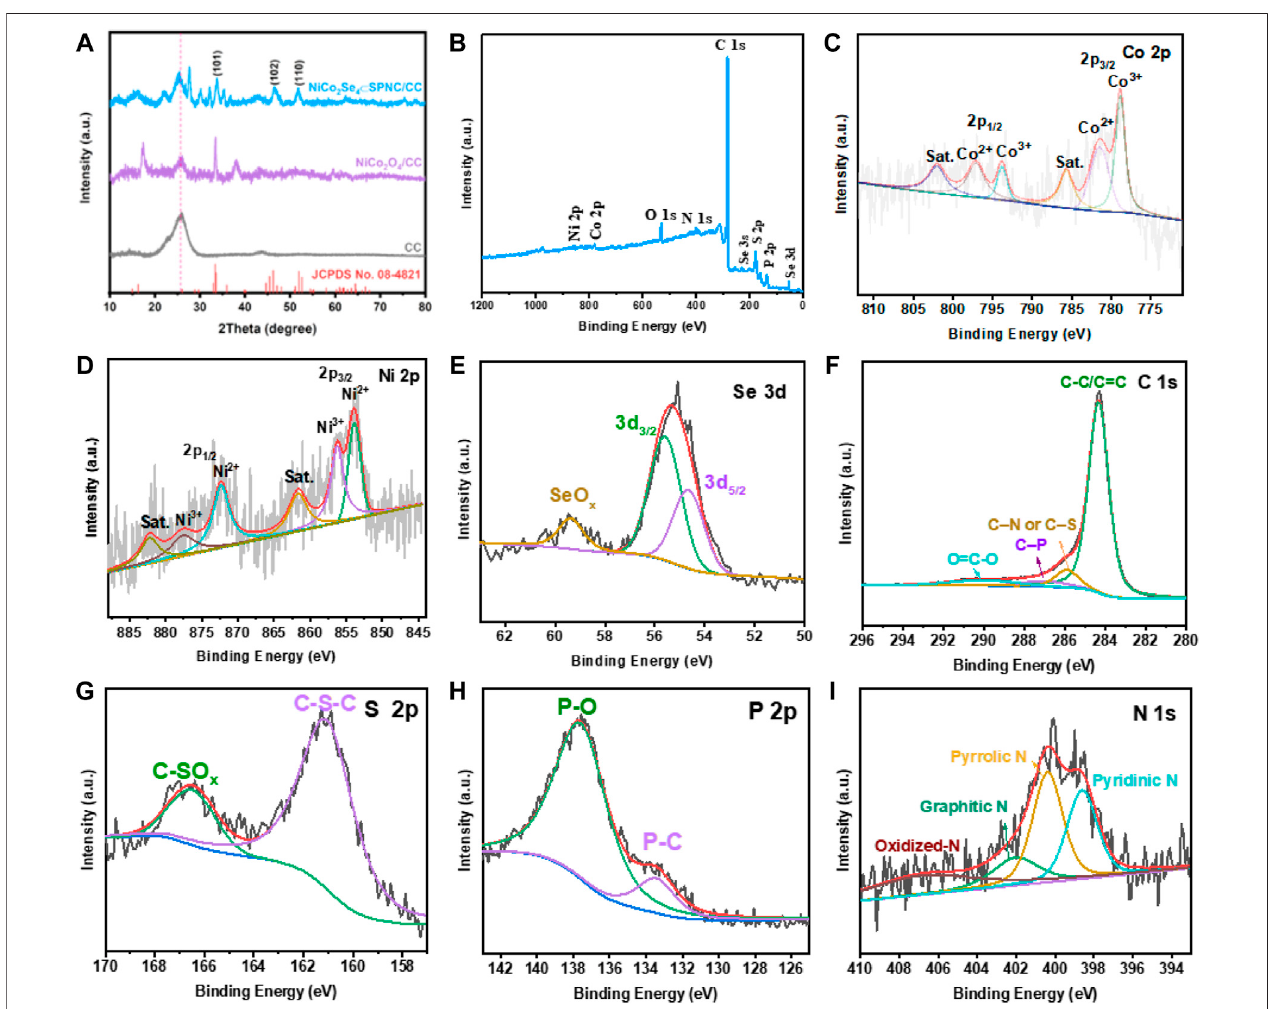
FIGURE 3 | (A) XRD patterns for the CC, NiCo 2 O 4 /CC and NiCo 2 Se 4 ⊂ SPNC/CC, (B) XPS survey spectrum of the NiCo 2 Se 4 ⊂ SPNC/CC, the high-resolution XPS spectra for (C) Co. 2p, (D) Ni 2p, (E) Se 3days, (F) C 1s, (g) S 2p, (H) P 2p, and (I) N 1s.